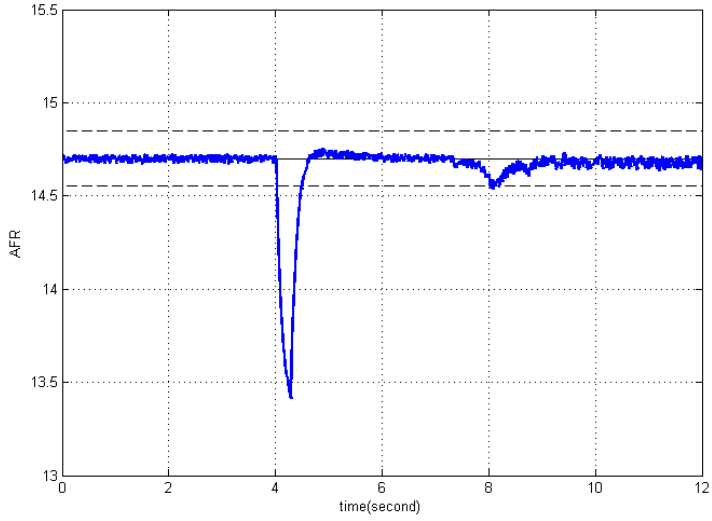
Figure 12. AFR control results.